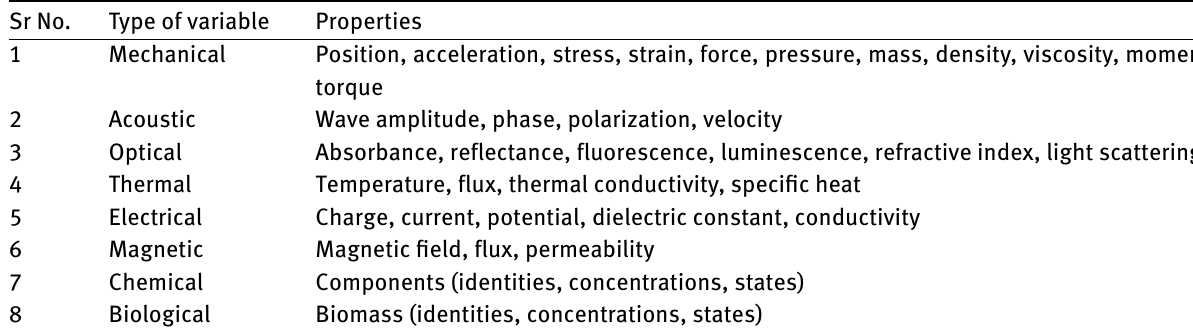
Table 1: Classification of nano-sensors based on the type of variable being detected [21] Sr